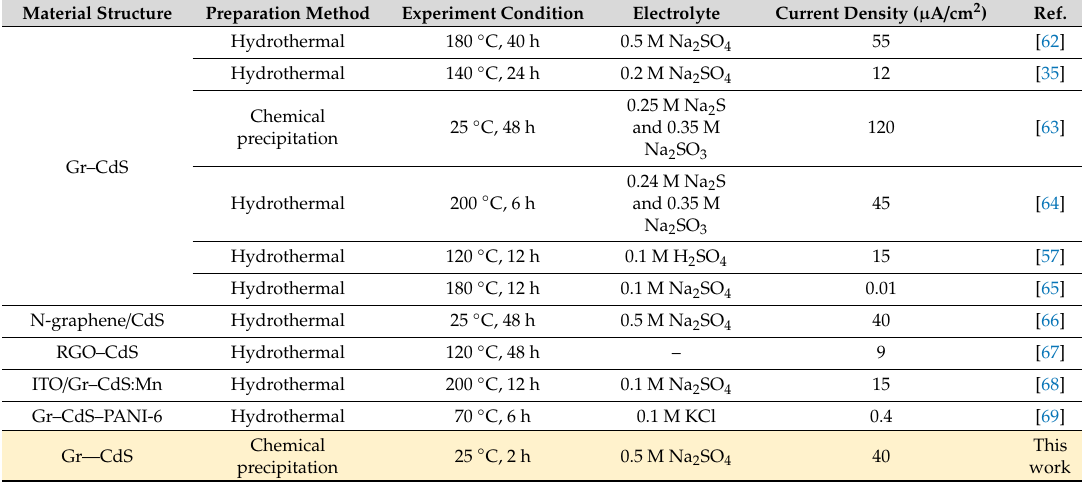
Figure 9. (a) Photocurrent density as a function of applied potential (V vs. RHE) under illumination and in the dark, (b) transient photocurrent response of Gr–CdS and pure CdS during periodic on–off light cycles, (c) photoconversion efficiency against an applied potential (V vs. RHE), and (d) EIS spectra of Gr–CdS and pure CdS. Table 3. Comparison of our photocurrent density results with recently reported results.